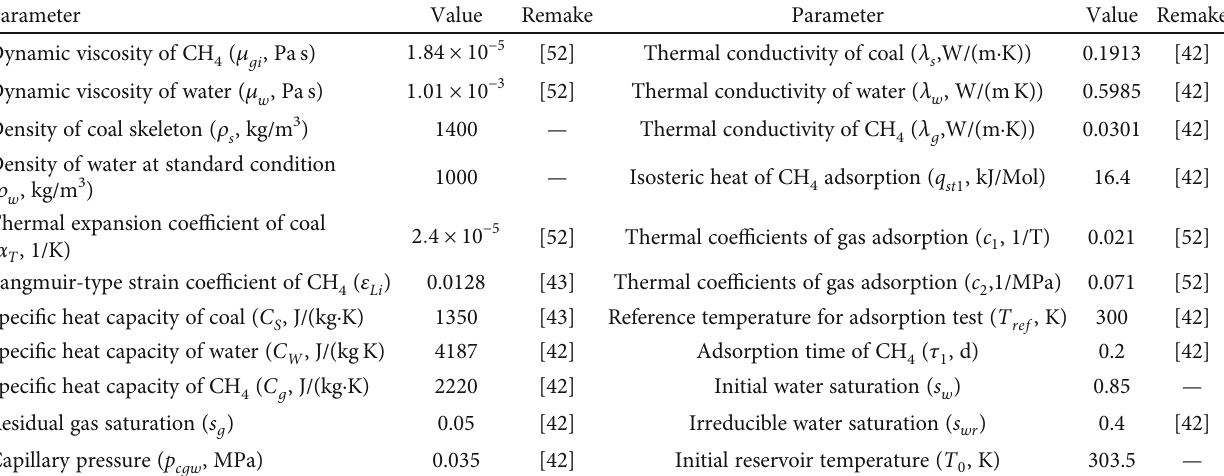
Table 1: Parameters for basic geological model.